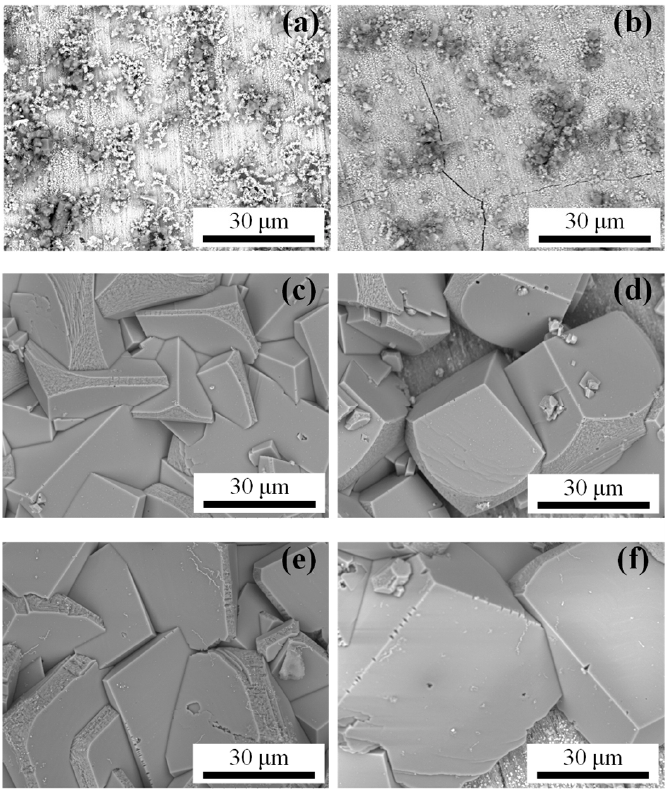
Figure 3. The product film morphology of N80 and 1Cr under three conditions: ( a , b ) 50 ◦ C-CO 2 : 0.30 MPa; ( c , d ) 100 ◦ C-CO 2 : 0.63 MPa; ( e , f ) 114 ◦ C-CO 2 : 0.73 Mpa. Note: ( a , c , e ): N80; ( b , d , f ): 1Cr. Table 5. EDS analysis of product fi lm of the specimens under di ff erent corrosion conditions (nor- malized mass percentage: less than 0.5% not listed).